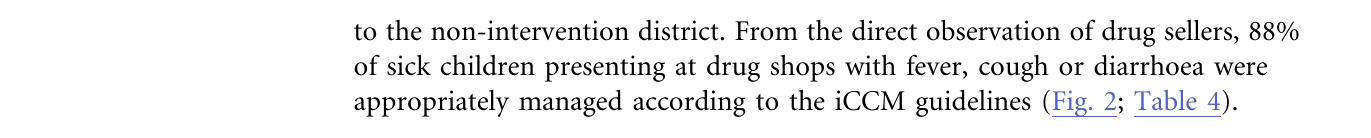
to the non-intervention district. From the direct observation of drug sellers, 88% of sick children presenting at drug shops with fever, cough or diarrhoea were appropriately managed according to the iCCM guidelines (Fig. 2; Table 4).